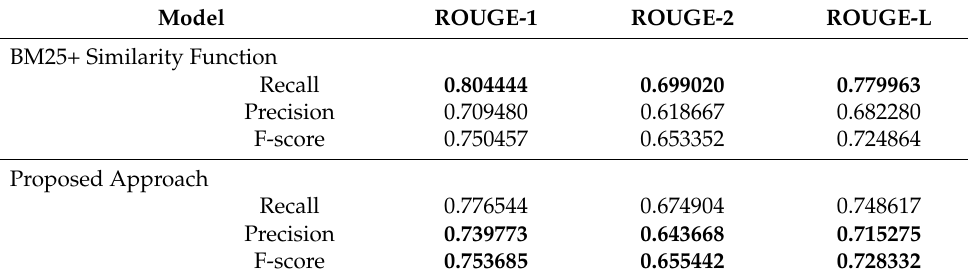
Table 3. Comparison of the proposed model with various state-of-the-art methods based on average F-scores (ROUGE metric).